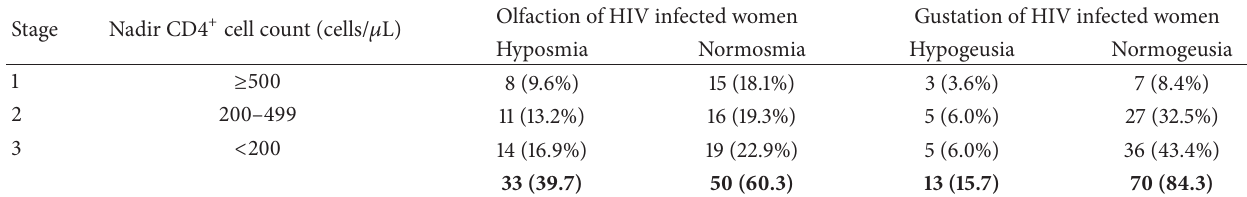
Table 5: Relationship of HIV infection stage with hyposmia and